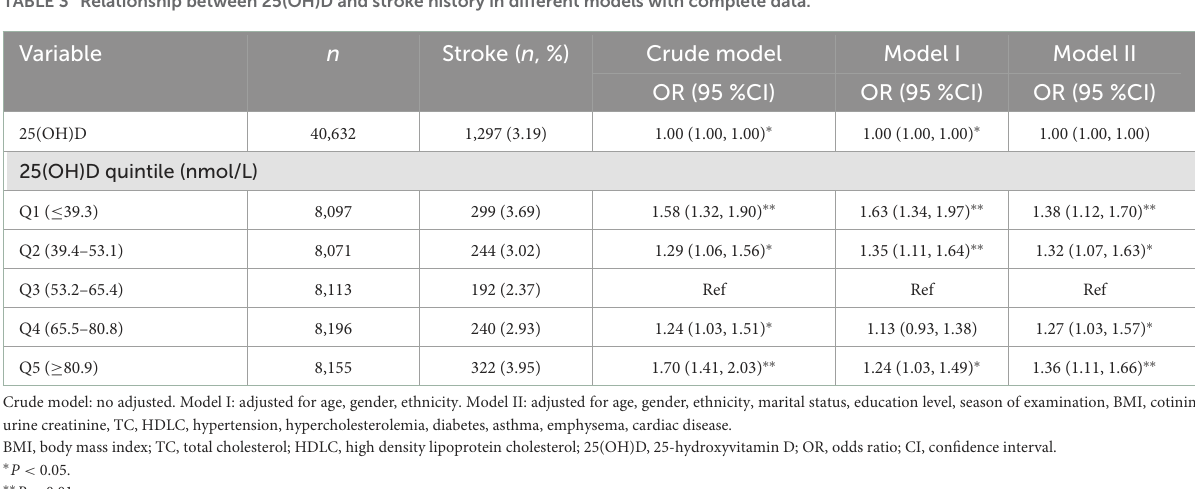
TABLE 3 Relationship between 25(OH)D and stroke history in different models with complete data.